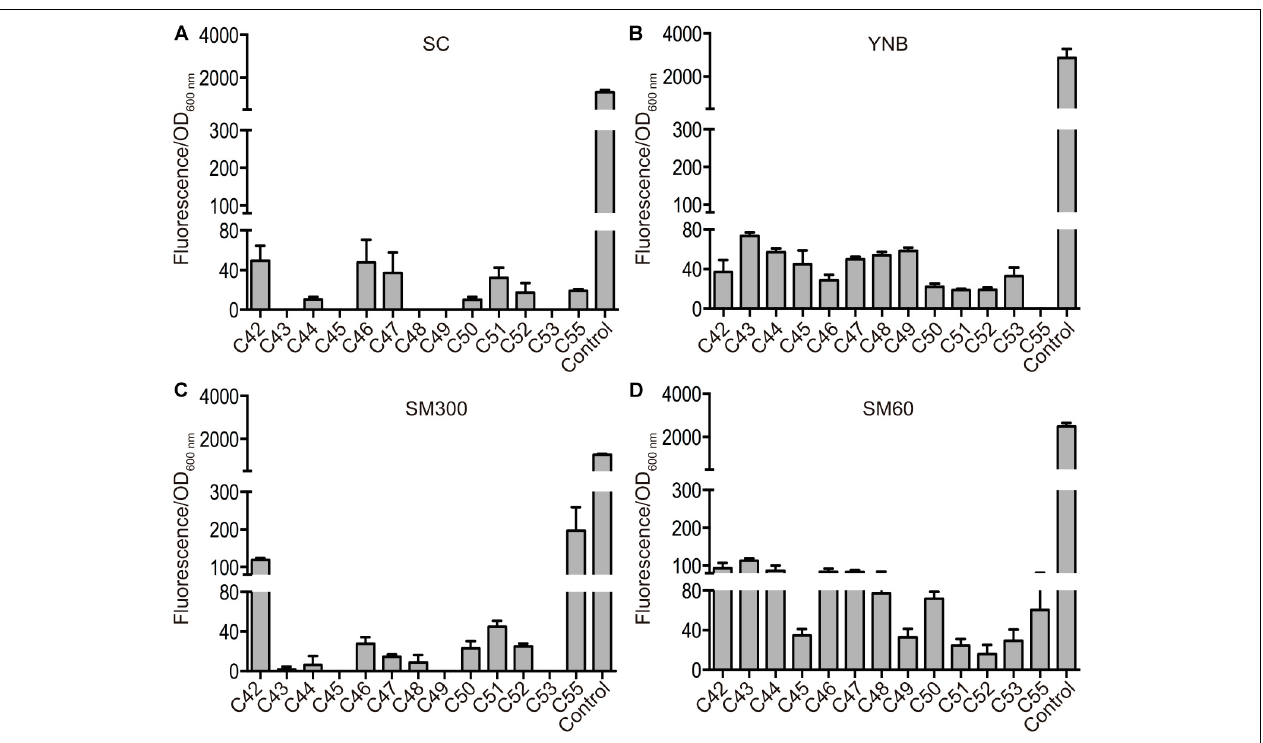
FIGURE 3 | Protein levels of horizontally acquired genes in region C. The protein levels produced by the ORFs inside region C were measured as normalized mCherry fluorescence in four culture conditions: SC (A) , YNB (B) , SM300 (C) , and SM60 (D) . The translational fusion of the THD3 gene was used as positive control in all the experiments. The average values of three independent biological replicas ( ± standard error) are